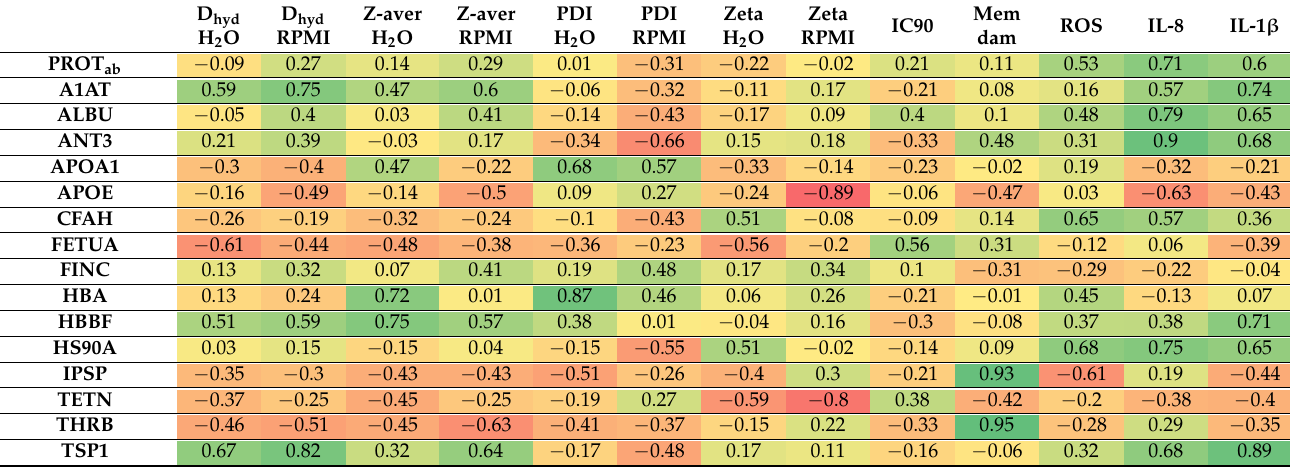
Table 3. Analysis of correlations (Spearman coefficient) between the protein corona composition and PCP: total protein abundance (PROT ab ), D hyd (diameter—peak by number distribution) in distilled water (H 2 O) and RPMI media (RPMI), Z-average size (Z-aver), zeta potential (Zeta), PDI, and toxicological endpoints: IC90, membrane damage (Mem dam), ROS, IL-8, and IL-1 β